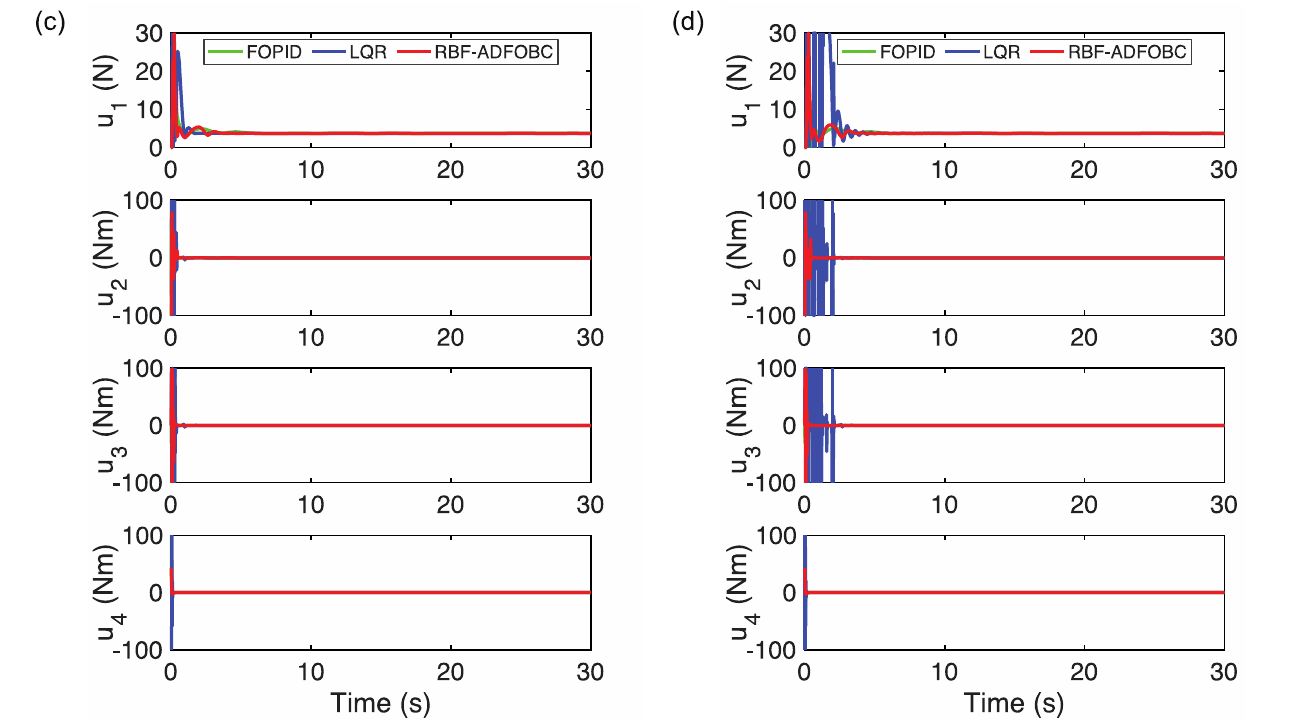
Figure 10. Comparison of the simulated control signals with three controllers ( 𝛽 = 0.5 in RBF-ADFOBC) in response to various payloads and uncertain input time delays: ( a ) d 3 = 2 m/s 2 and τ = 0.05 s, ( b ) d 3 = 2 m/s 2 and τ = 0.10 s, ( c ) d 3 = 4 m/s 2 and τ = 0.05 s, ( d ) d 3 = 4 m/s 2 and τ = 0.10 s. (Assume that d 1 = d 2 = d 4 = d 5 = d 6 = 0 and τ = τ 1 = τ 2 = τ 3 = τ 4 .) Table 20. Comparison of the root mean squared value of the control signals in the three controllers under different payloads, different input time delays and different fractional orders.